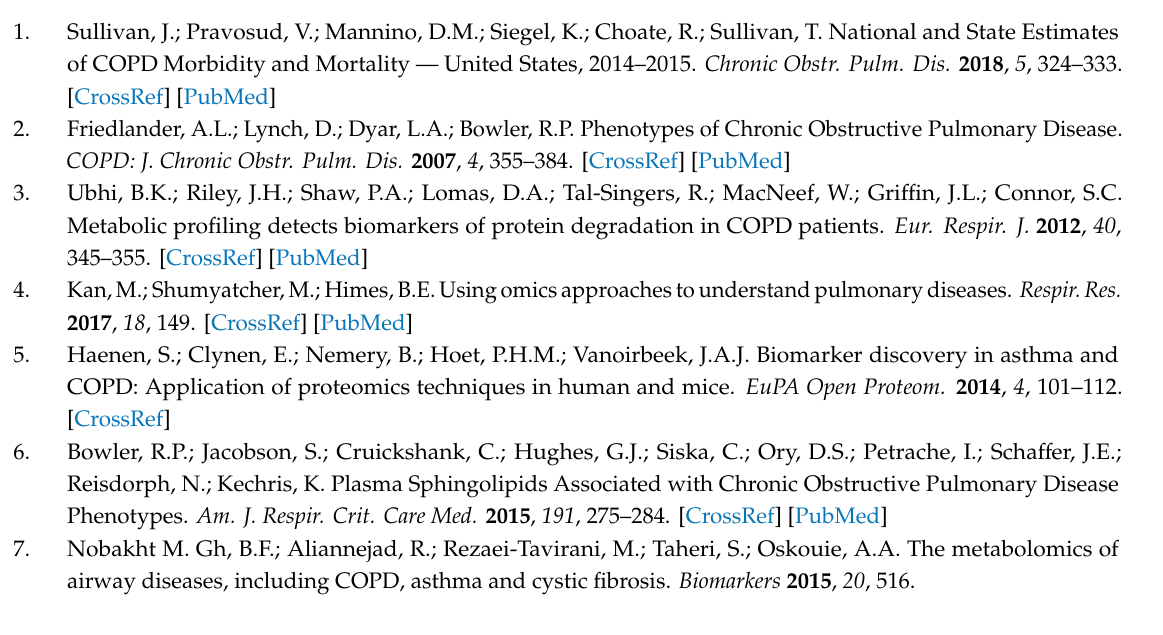
based on compound profiles; Figure S5: Full WGCNA Module Eigenvalue to Phenotype. Relationship in Plasma; Figure S6: WGCNA Module Eigenvalue to Phenotype Relationship in. BAL for BAL Cell